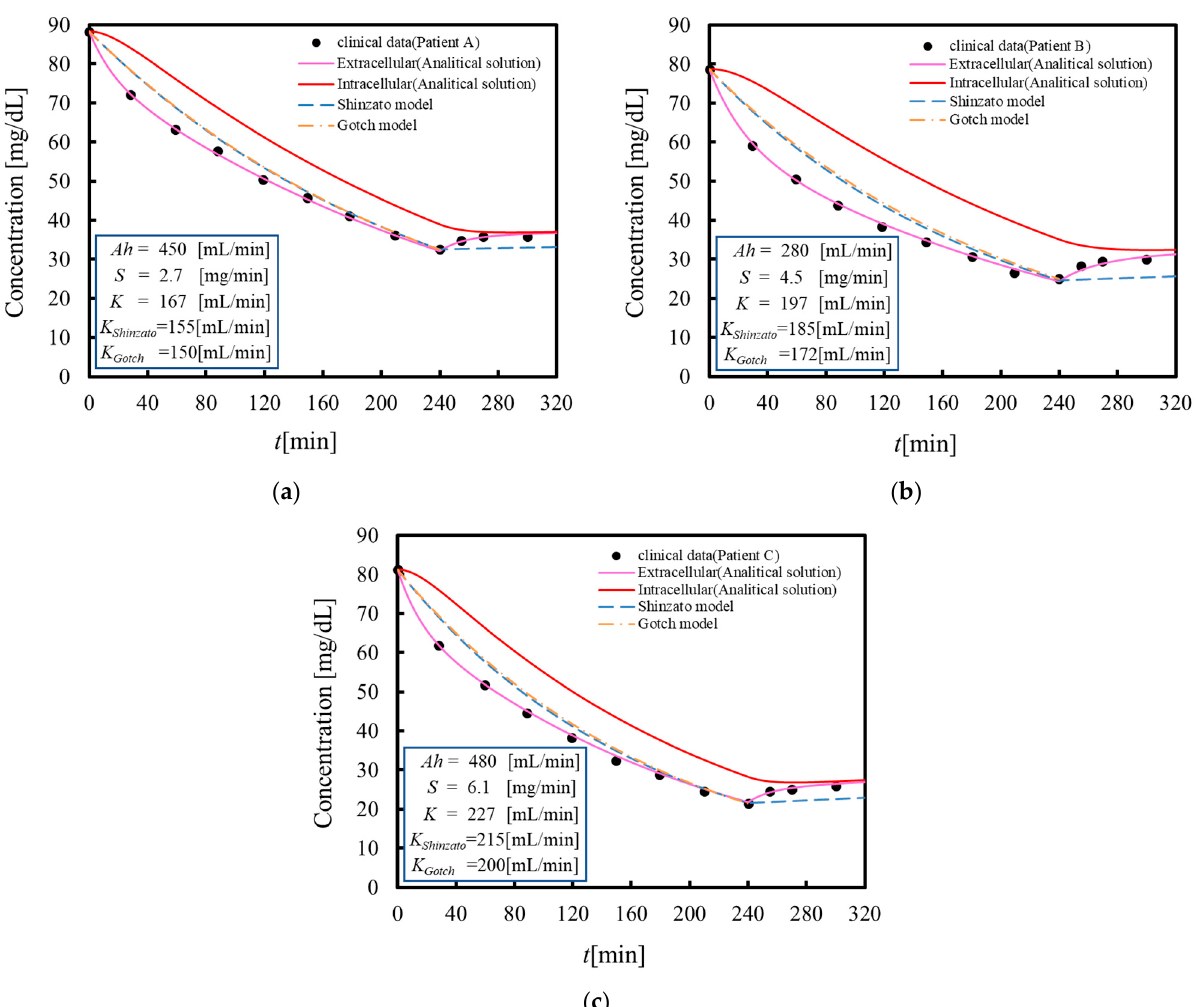
Figure 4. Blood urea concentration reproduced by the proposed analytical solutions, Gotch formula and Shinzato formula. ( a – c ) show the case of clinical data of chronic dialysis patients A, B and C, respectively. The proposed analytical solution accurately reproduces the behavior of measured blood urea levels during and after dialysis. This demonstrates the usefulness of the proposed analytical solution.